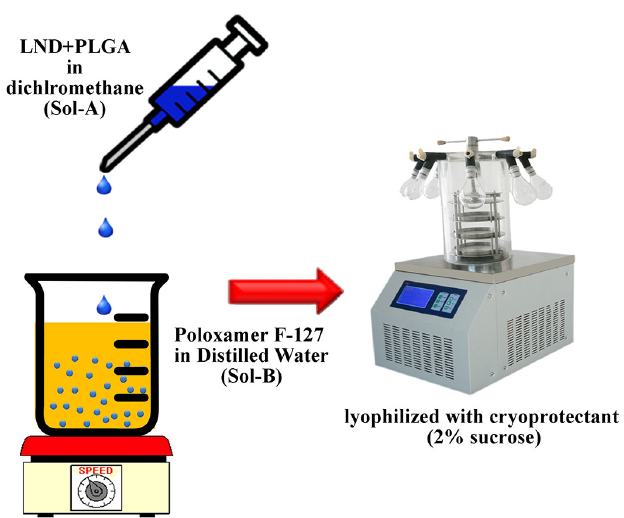
FIGURE 1 - Schematic representation of preparation of